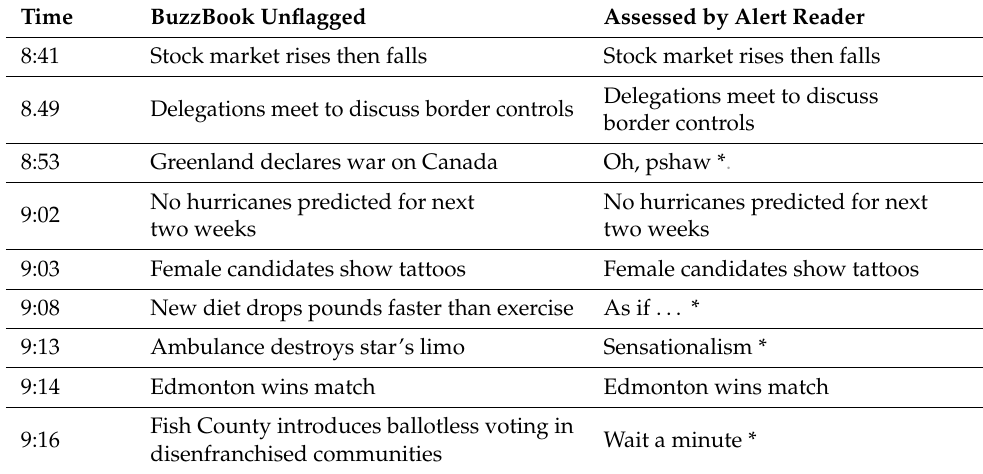
Table 1. Headlines as understood by reader exercising